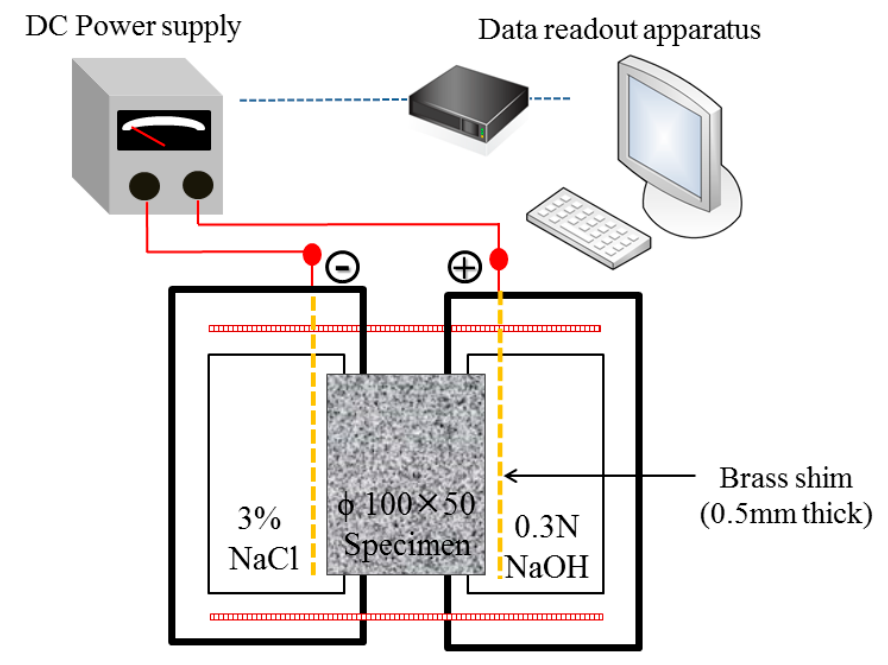
Figure 10. Schematic diagram of accelerated chloride migration test.